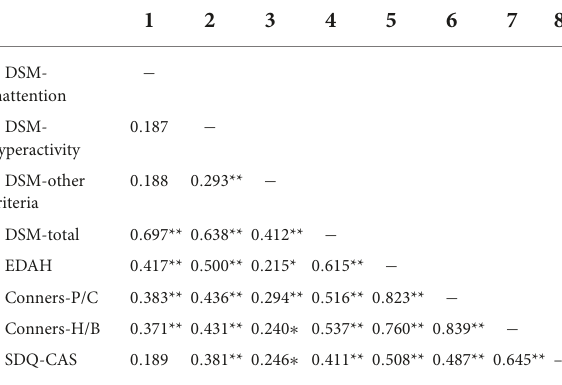
TABLE 4 Correlation coefficients between instruments (Spearman’s